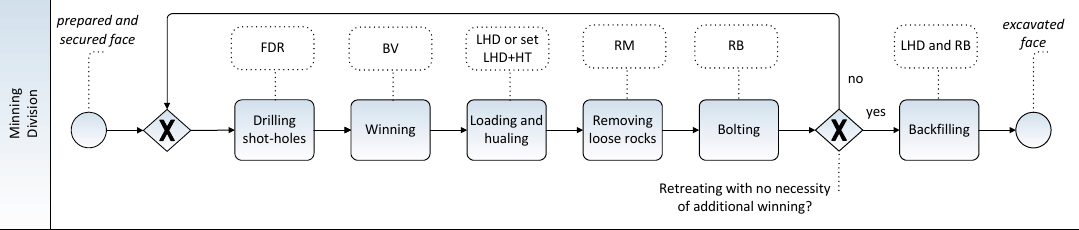
Figure 1. Copper ore mining process recorded in business process model and notation (BPMN) [22].